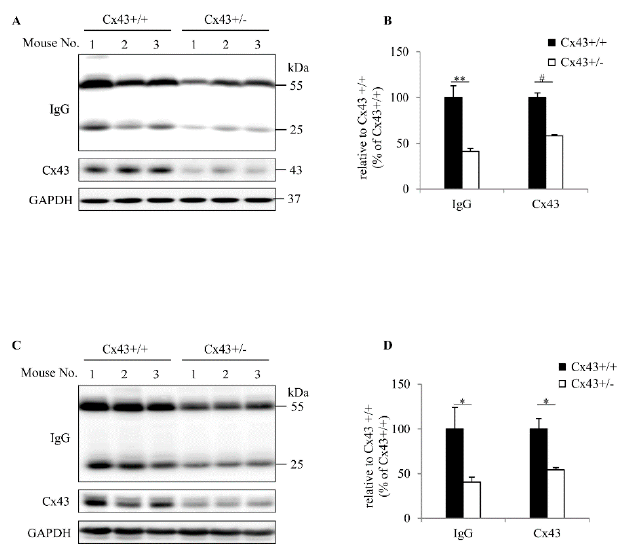
Figure 1. Immunoglobulin (IgG) levels in the tissue samples of connexin (Cx)43 +/+ and Cx43 +/ − mice. Protein lysates extracted from the normal tissues of Cx43 +/+ and Cx43 +/ − mice were subjected to Western blot analysis for IgG and Cx43. GAPDH was used as an internal control. Level of IgG and Cx43 in liver and kidney was shown in ( A ) and ( C ), respectively. The densitometric quantitation of IgG and Cx43 bands in ( A ) and ( C ) are shown in ( B ) and ( D ). Data shown are mean ± SE ( n = 10 for IgG; n = 3 for Cx43). * p < 0.05, ** p < 0.01, # p < 0.001. Int. J. Mol. Sci. 2019 , 20 , x FOR PEER REVIEW